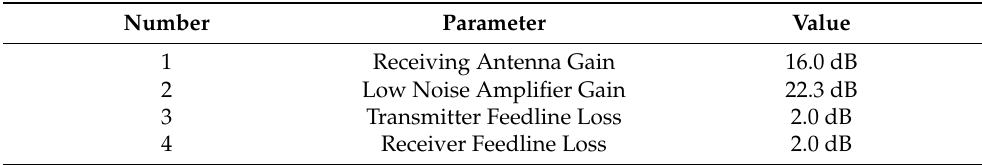
Table 2. Equipment parameters in the over − the − horizon propagation experiment.